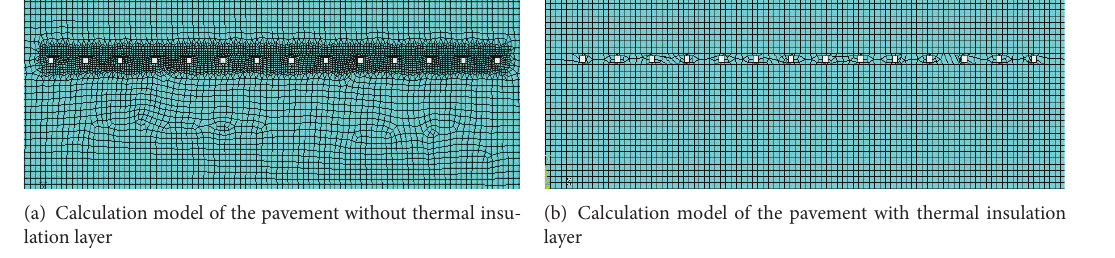
Figure 15: Calculation model of the pavement.